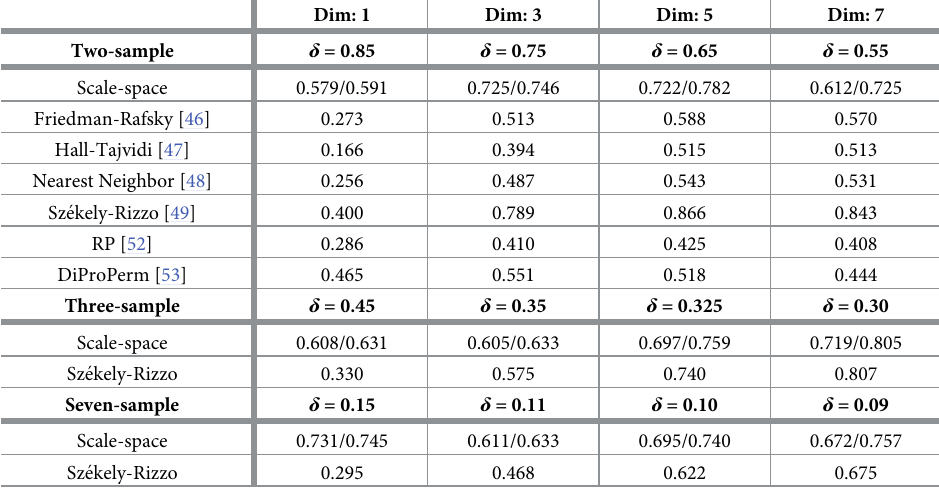
Table 2. Power of comparing a number of different data sets with a varying number of dimensions (“Dim”) for which there is an expected value difference δ in the tested data sets. For the Hall test, the T and S tests gave very sim- ilar results. Three nearest neighbors were used in the Nearest Neighbor test. The results of the Friedman-Rafsky test are for three trees, which consistently performed better than one and two trees in this setting. The scale-space results are for the Bonferroni/FDR correction, respectively. A 0.10 significance level is used and 2000 Monte Carlo samples are used. Dim: 1 Dim: 3 Dim: 5 Dim: